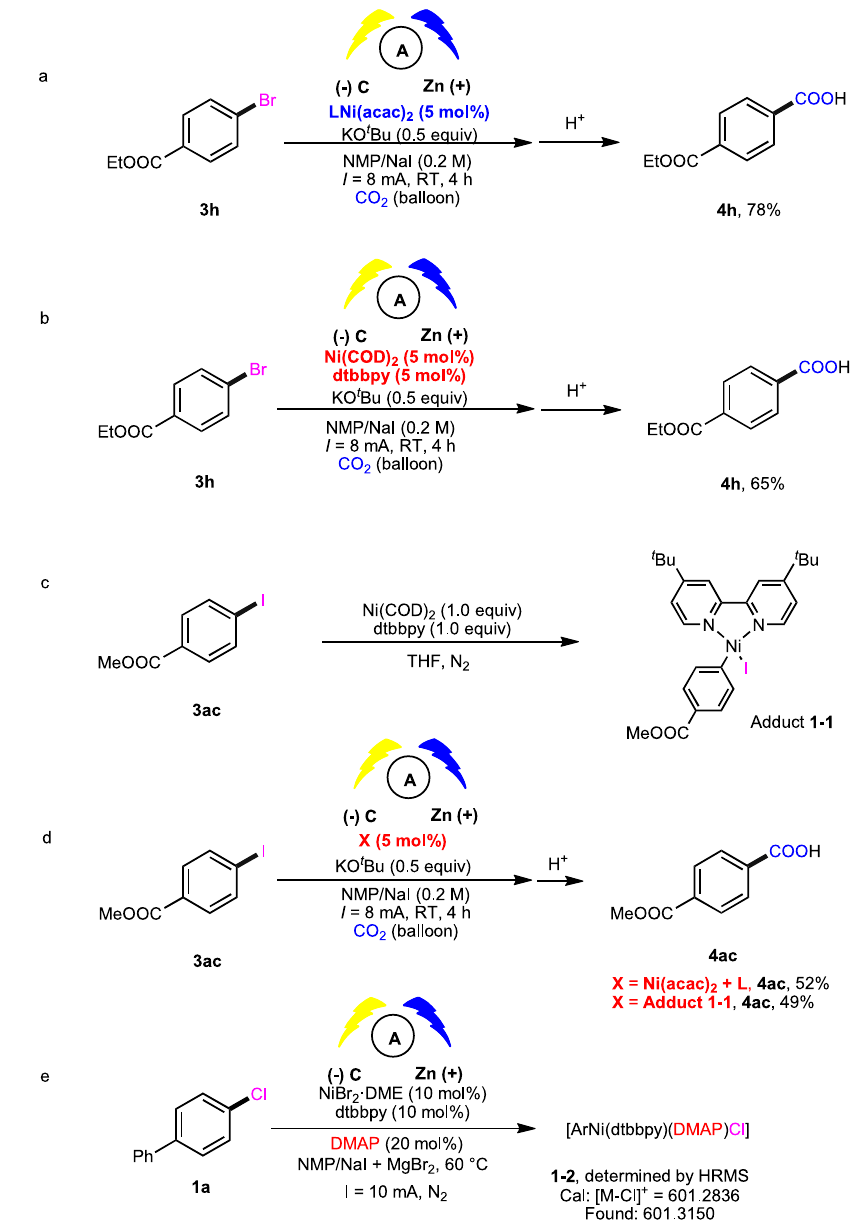
Fig. 5 Control experiments. a Investigation of the effect of nickel complex LNi(acac) 2 . b Investigation of the effect of Ni(0) catalyst. c Preparation of oxidative addition adduct 1-1 . d Investigation of the effect of adduct 1-1 . e HRMS detection of oxidation addition adduct. L = dtbbpy. DMAP = N, N